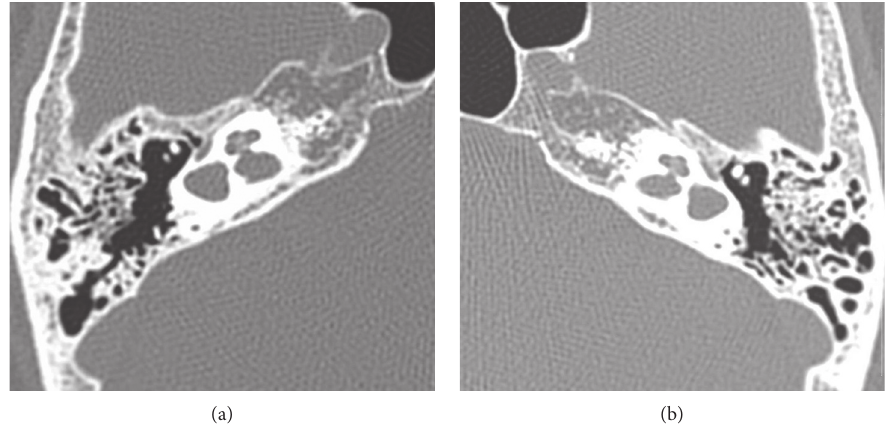
Figure 2: HRCT. The fusion of the vestibules and the lateral semicircular canals. (a) Right ear. (b) Left ear.